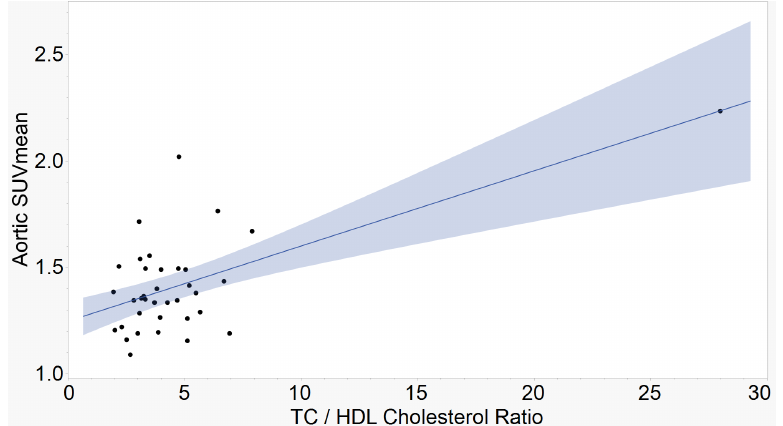
Figure 1. Aortic SUVmean vs. Castelli’s Risk Index I (CRI-I). The ratio between total cholesterol and high-density lipoprotein cholesterol demonstrates a strong, positive correlation with mean tracer uptake in the aorta. (r = 0.63, p < 0.0001, n = 36).